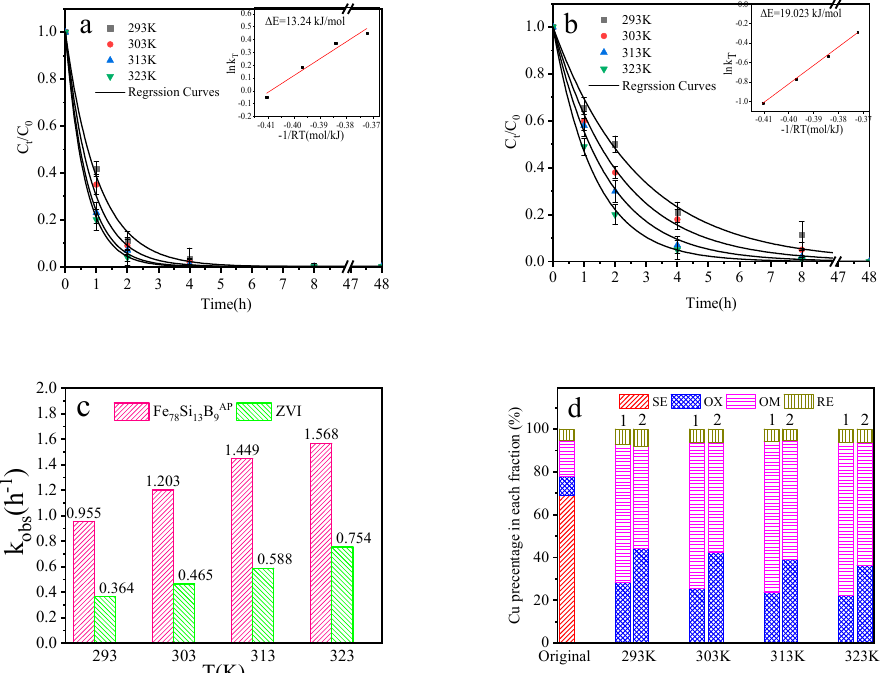
Figure 2. Effect of temperature on the immobilization process of ( a ) Fe 78 Si 9 B 13AP and ( b ) ZVI. Insert: The Arrhenius plot of lnk T versus − 1/room temperature (RT) for the remediation of Cu 2+ ions by ( a ) Fe 78 Si 9 B 13AP and ( b ) ZVI. ( c ) Apparent reaction rate. ( d ) Influence of temperature on the fractions of different Cu forms after a 200 h treatment. (1: Fe 78 Si 9 B 13AP : Treated soils, 2: ZVI: Treated soils).